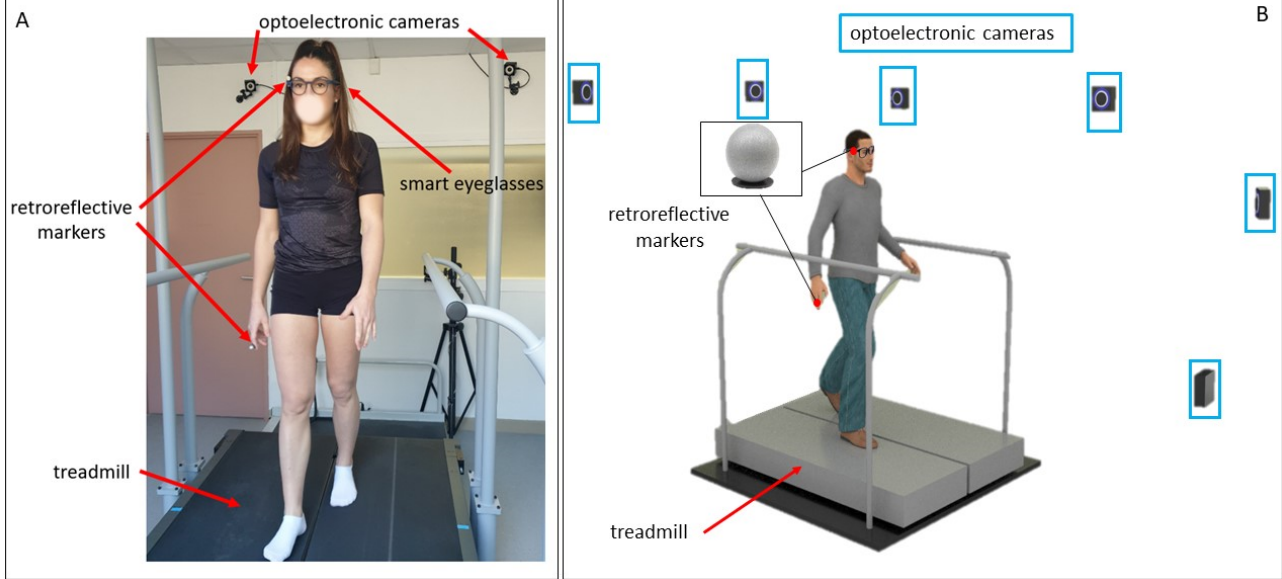
Figure 1. Participant walking on the treadmill with the equipment set up ( A ) and 3D schematic representation of the gait analysis laboratory ( B ).